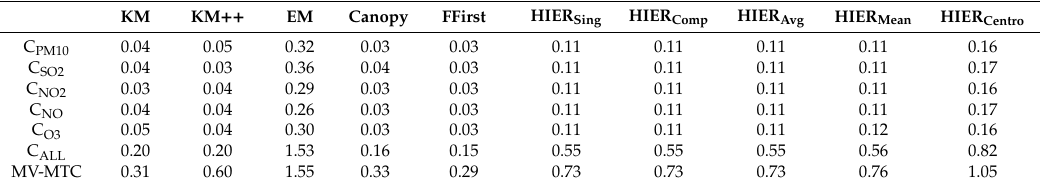
Table 10. Comparisons of di ff erent clustering methods in terms of execution time (in